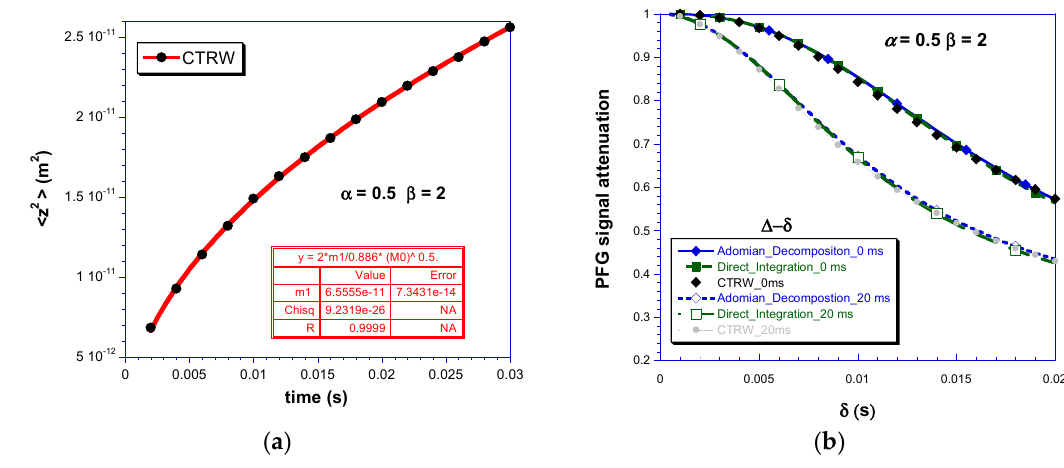
Figure 2. Comparison of the PFG signal attenuation from theoretical predictions with continuous-time random walk (CTRW) simulation: ( a ) mean square displacement from CTRW simulation; ( b ) PFG signal attenuation from different methods: the Adomian decomposition method with Equations (22a)–(22c), the direct integration method with Equation (32), and the CTRW simulation. The parameters used are α = 0.5, β = 2, D f = 6.6 × 10 − 11 m β /s α , and g = 0.1 T/m.